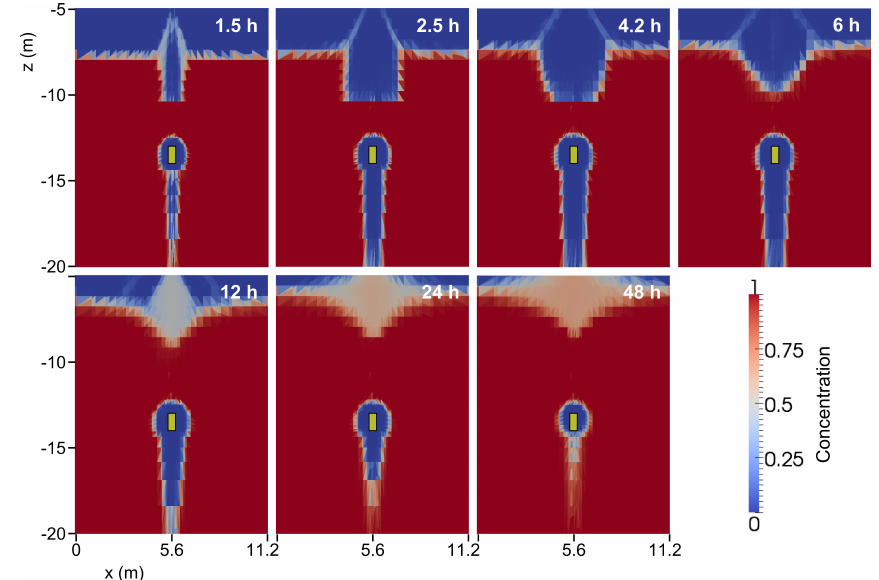
Figure 10. Flow and transport modeling results at different times (in hours after start of injection) for scenario 4 (see Table 2).